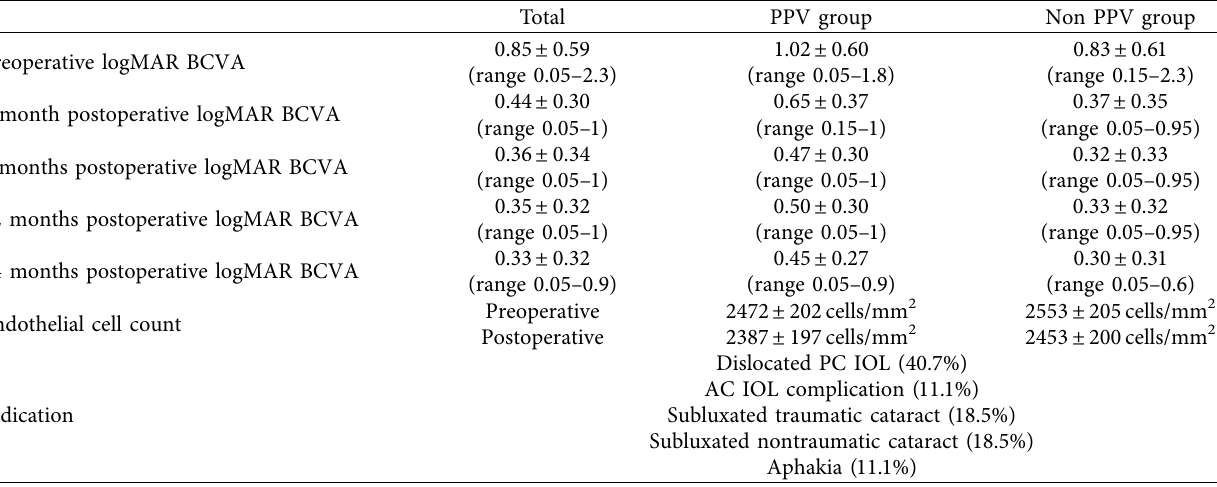
Table 2: Results.